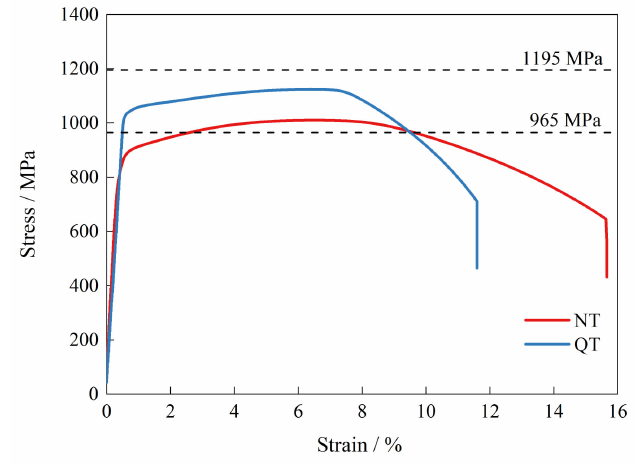
Figure 4. The engineering tensile stress-strain curves of NT and QT samples.